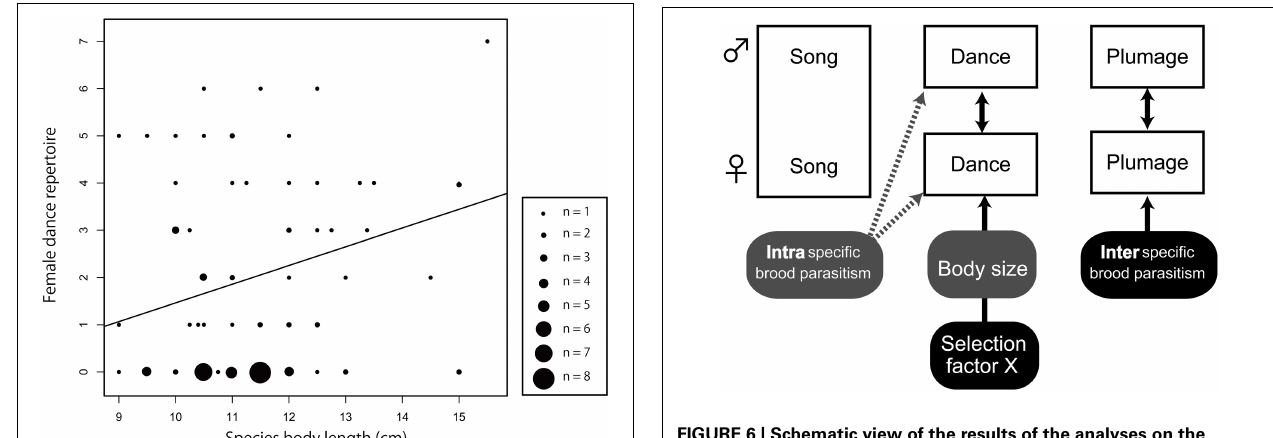
FIGURE 6 | Schematic view of the results of the analyses on the evolution of three sexual signals. Two headed arrows show correlated evolution between sexes, and one-headed arrows show factors responsible for trait evolution. Marginal effects are shown with dashed arrows. The figure summarizes the results from Tables 1 – 3